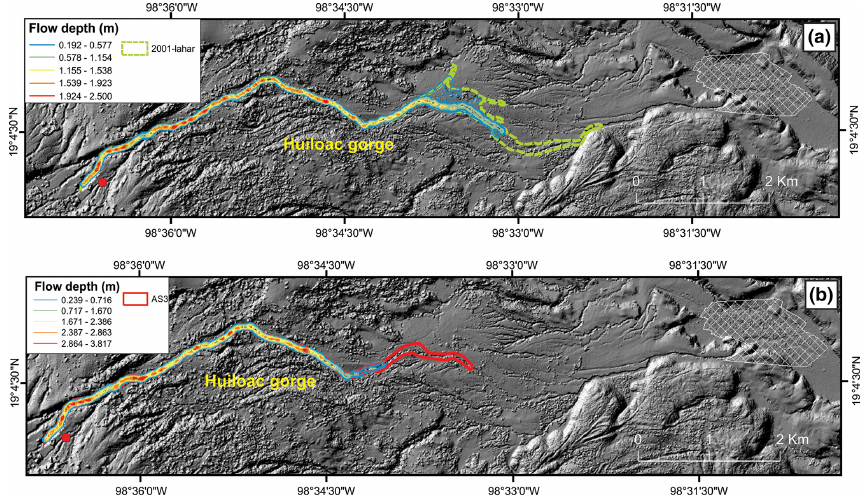
Figure 11. Lahar simulation with the 30m DEM. (a) 2001 lahar simulation. (b) Simulation of AS3 (more viscous lahar). Green (a) and red (b) lines indicate simulation results with the 10m